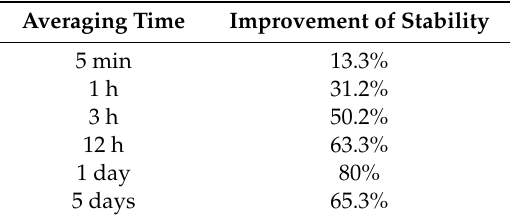
Table 2. The stability improvements applying integer ambiguity resolution to Atomium PPP (GPS). Averaging Time